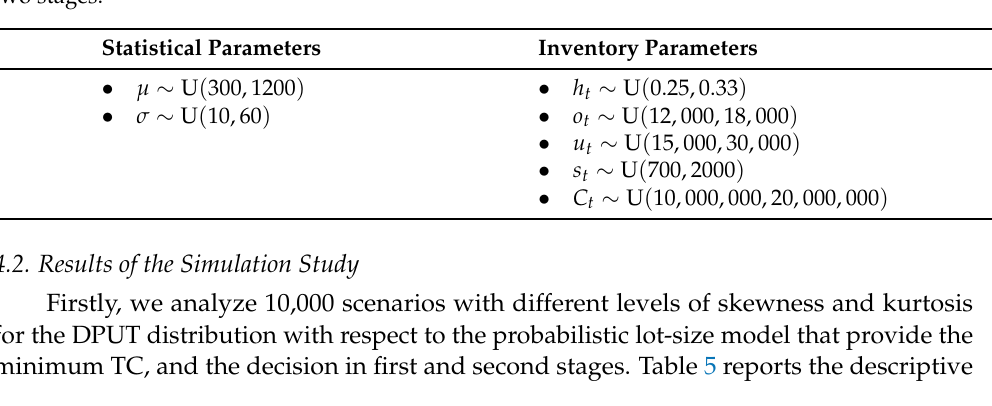
Table 4. Parameters used to generate 10,000 scenarios for inventory policies obtained by SP in two